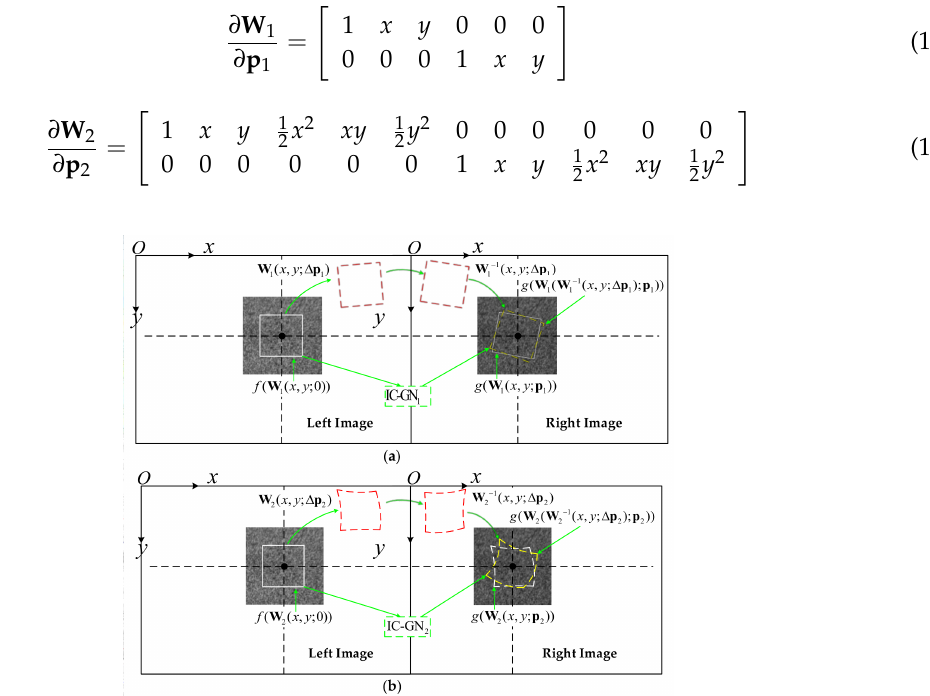
Figure 1. Schematic principle of DIC-based stereo matching using IC-GN algorithm: ( a ) First-order warp function; and ( b ) Second-order warp